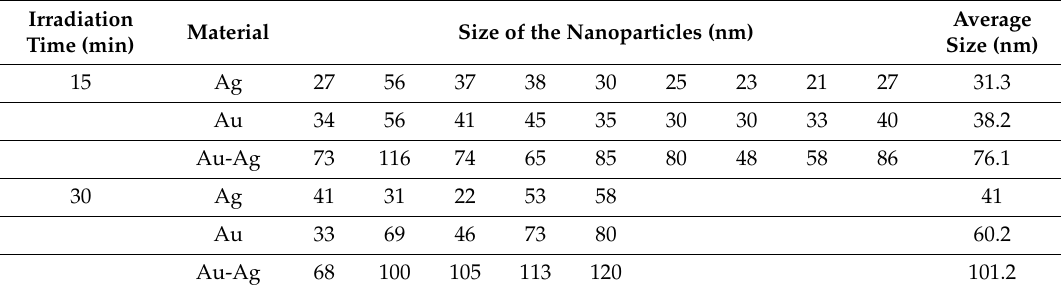
Figure S1: Elemental characterization of conjoined Au-Ag nanotwins formed by prolonged irradiation (more than one hour) of the seed in the seeding step and 30 min in the second (feed)